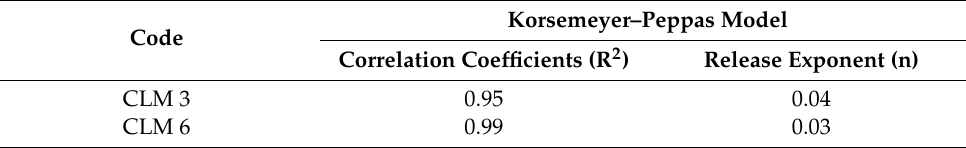
Table 4. In vitro clarithromycin release kinetics from optimized